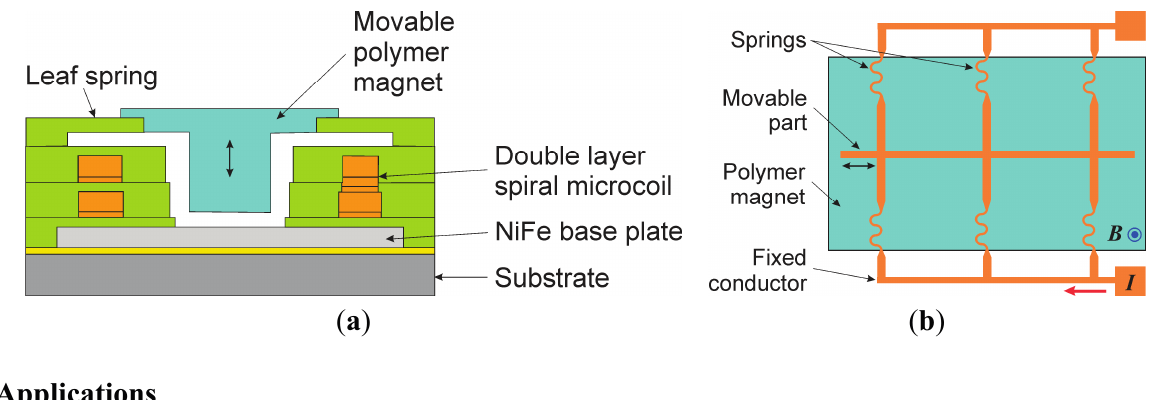
Figure 6. Schematic views of magnetic microactuators (according to [32]): ( a ) plunger coil actuator and ( b ) linear Lorentz force